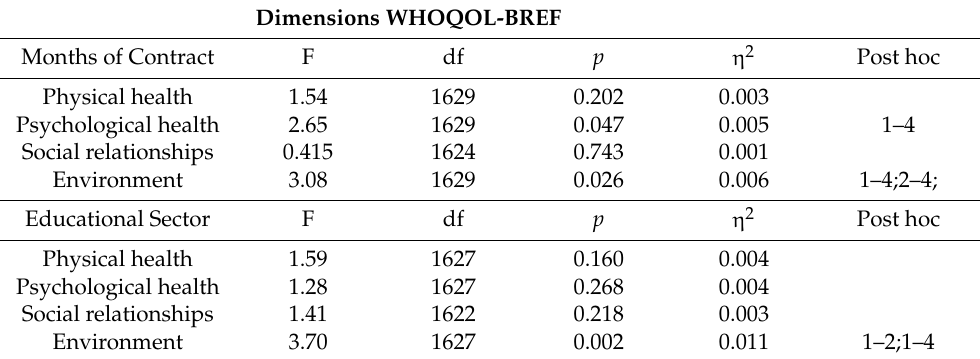
Table 6. Student’s t -test results according to length of contract in months (job stability) and